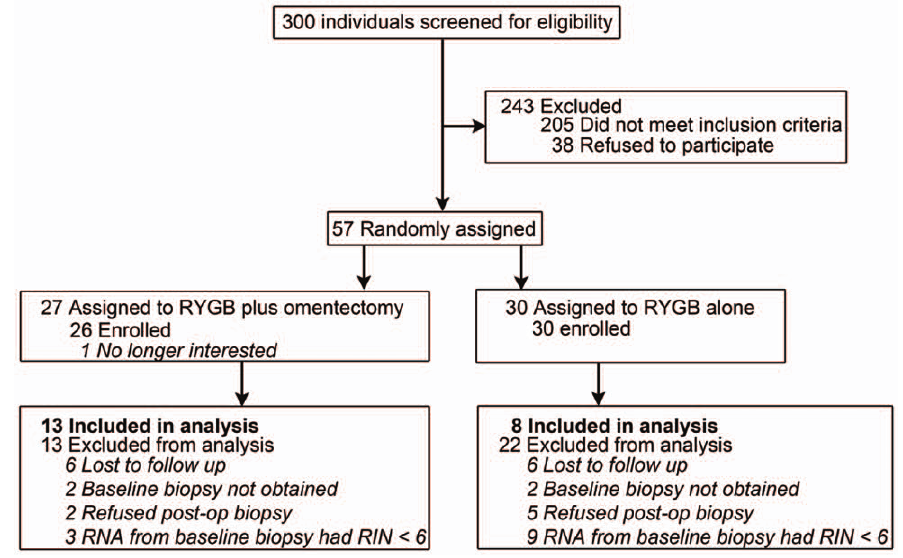
Figure 1. CONSORT Diagram.